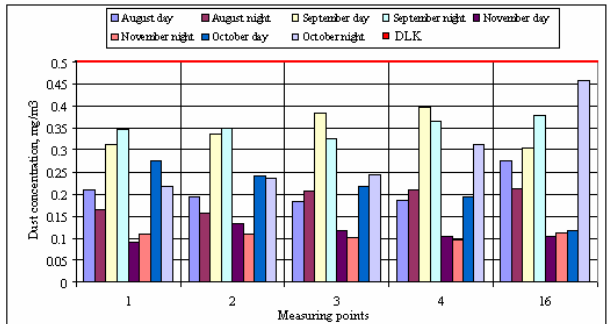
Fig 11 . Data of testing dustiness in the northern part of Klaip ė da city The highest concentration, detected behind the